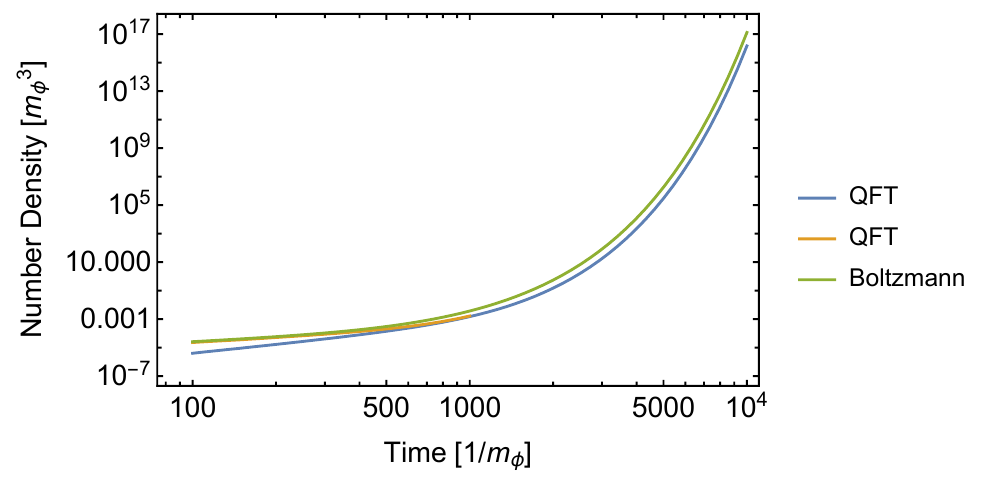
) for q = 10 − 2 , adopting the integration regions Figure 3 . Evolution of n (QFT) χ (in units of m 3 φ of | ω − 1 m φ | ≤ 1 qm φ and 5 qm φ (blue and orange, respectively). We also show the evolution of 2 4 2 n (Boltzmann) χ